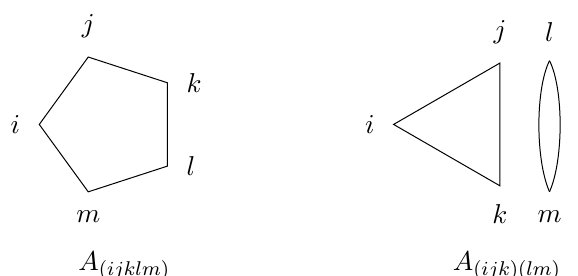
Figure 1. Each line between points i and j corresponds to a factor of t ij . We can then see that there are two types of structures, A and A , with one and two closed cycles ( ijklm ) ( ijk )( lm ) respectively. Note that each cycle is invariant under cyclic permutations and re(cid:13)ection, so the number of independent structures is given by the number of ways to distribute the points into the cycles, modulo those